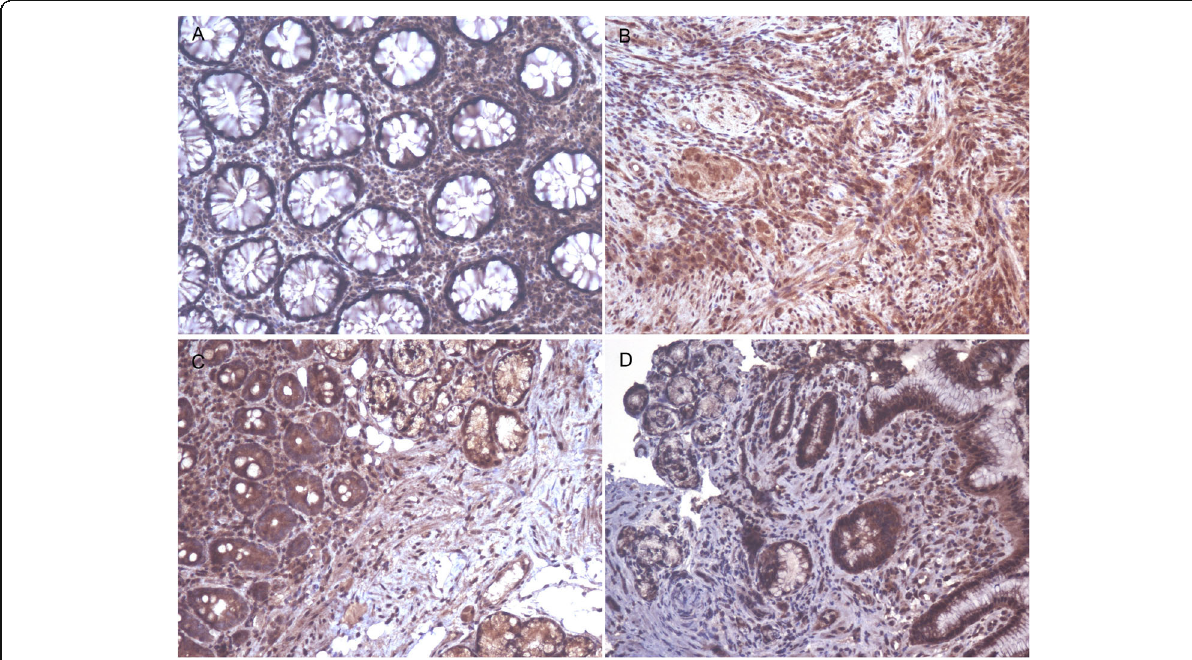
Fig. 2 Expression of PDGFR α and Nrp2 in different sites of the gastrointestinal tract in patients with HIV/AIDS and CMV. ( A ) Expression level of PDGFR α on mesenchymal cells was higher than epithelial cells in colon. IHC, original magnification 200×. ( B ) Expression of Nrp2 on hyperplastic mesenchymal cells in areas with ulcers in colon. IHC, original magnification 200×. ( C ) Expression level of Nrp2 on epithelial cells was higher than mesenchymal cells in duodenum. IHC, original magnification 200×. ( D ) Expression level of PDGFR α on epithelial cells and mesenchymal cells was similarly in the gastric antrum. IHC, original magnification 200